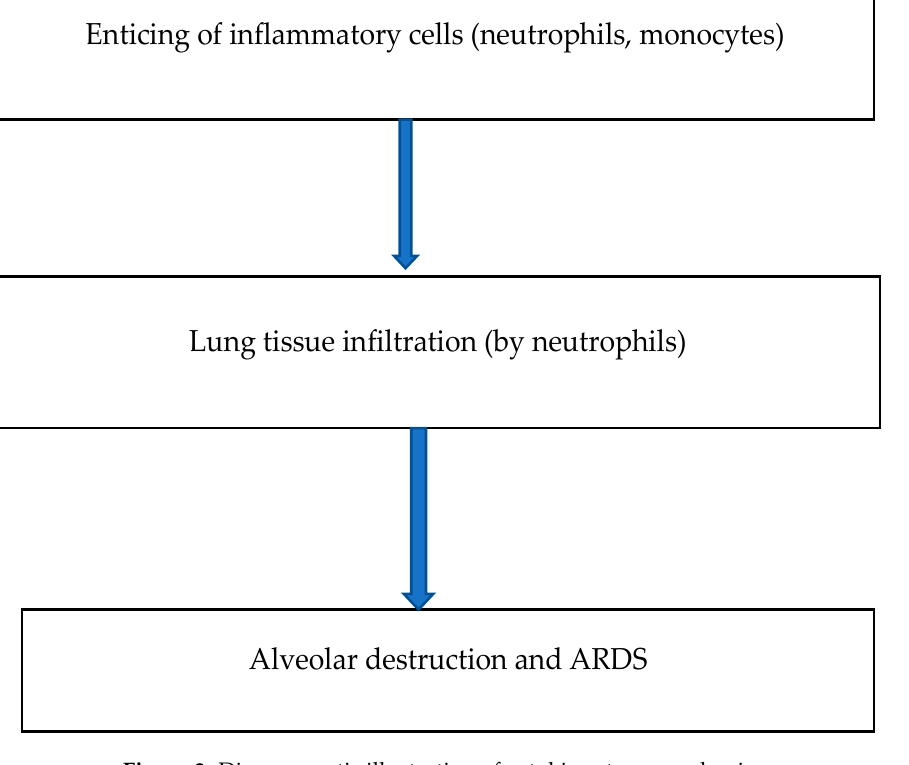
Figure 3. Diagrammatic illustration of cytokine storm mechanism.